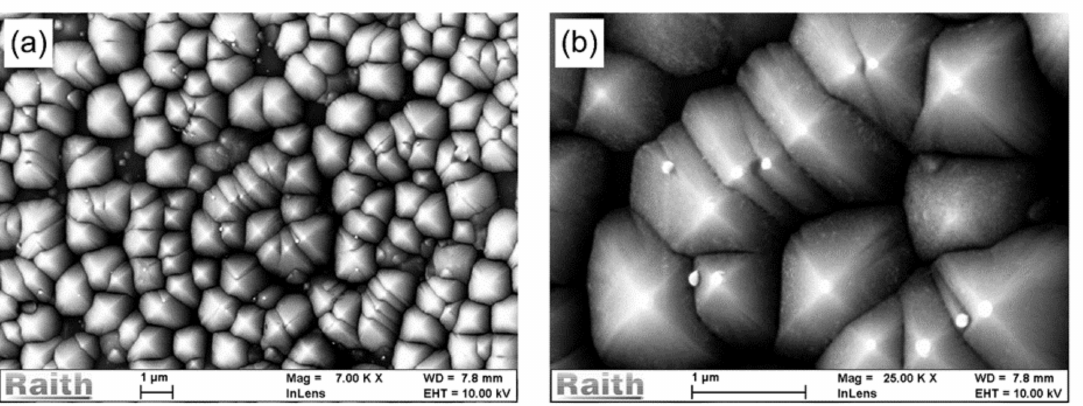
Figure 2. Scanning electron microscope (SEM) micrographs of the silicon surface etched in a 30 wt% KOH aqueous solution at 65 ◦ C for 10 min. Magnification: ( a ) 7000 × and ( b ) 25000 × .